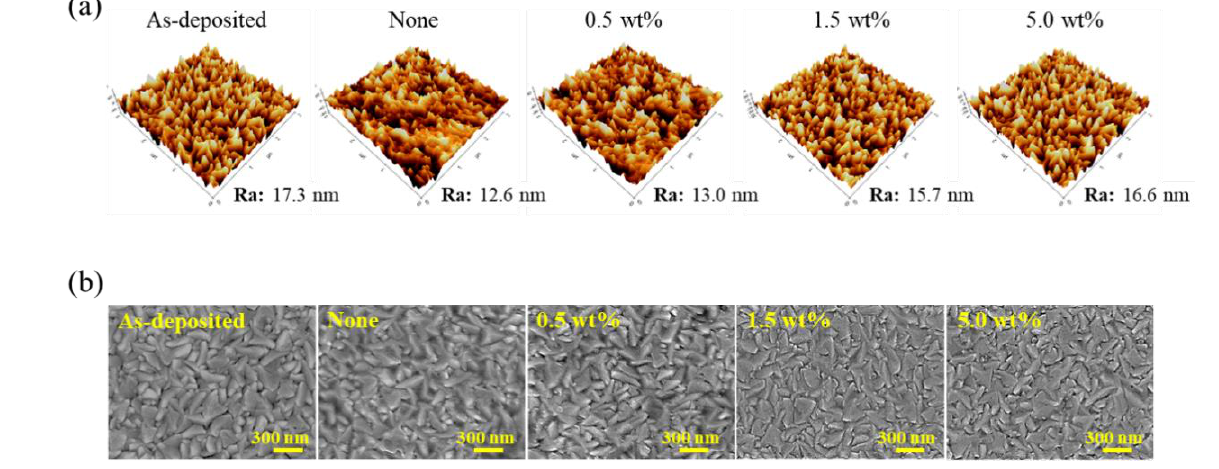
Figure 2. ( a ) Atomic force microscopy (AFM) and ( b ) scanning electron microscope (SEM) images of tungsten films after the dipping test as a function of picolinic acid concentration.